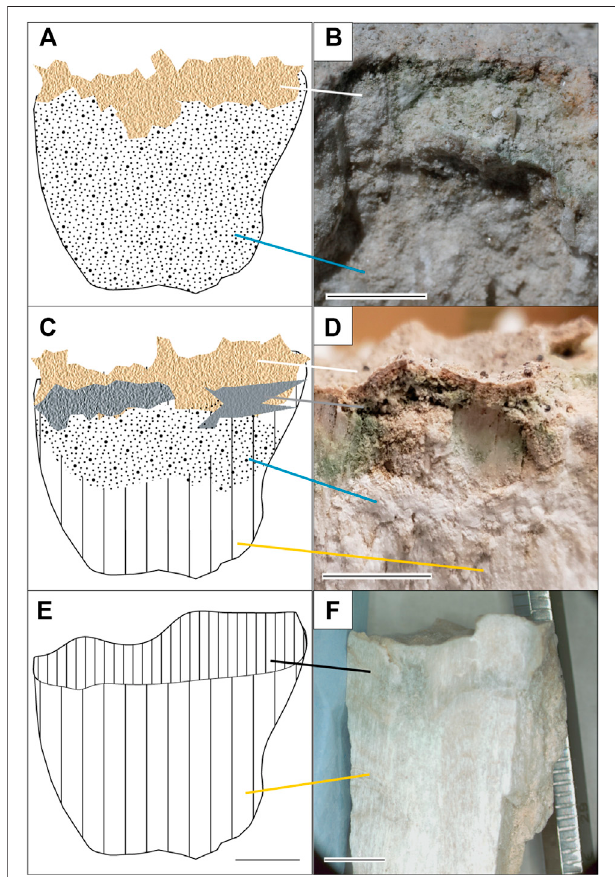
FIGURE 8 | Surface textures on gypsum. (A) Duricrust comprises a tan crust (white line) that overlies and is fully attached to the alabaster gypsum surface (blue line). Gypsum may have either selenite or alabaster habit, but alabaster is used here to match the image. Scale bar for (A,C,E) is ca. 1 cm. (B) Imageofduricrust.Scalebaris1 cm. (C) Bulboustexturecomprises detached duricrust (white line) over the gypsum surface, which is drawn here asalabaster (blueline)aboveselenite(yellowlone)tomatchtheexample.Gray line connects void space beneath the detached crust. Duricrust and bulbous texture are diagnostic for the presence of alabaster (Warren-Rhodes et al., in review). (D) Image of duricrust and bulbous texture. Scale bar is 1 cm. (E) Gypcrete comprises a denser selenite texture (black line) where pore space hasbeen fi lledwithsecondarygypsum.Gypcreteoverliesselenite(yellowline). (F) Image of gypcrete. Scale bar is 1 cm.